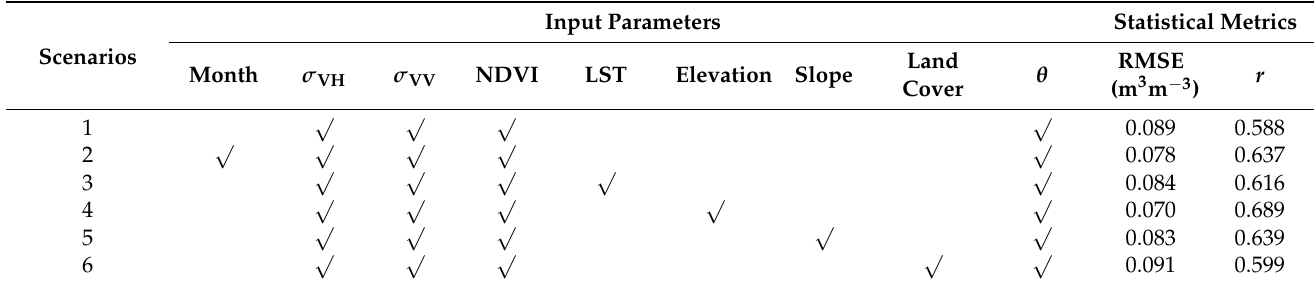
Table 7. Scenarios of different input parameter combinations and corresponding performances of SMC retrieval. Ticks indicate that the parameters are chosen as input scenarios